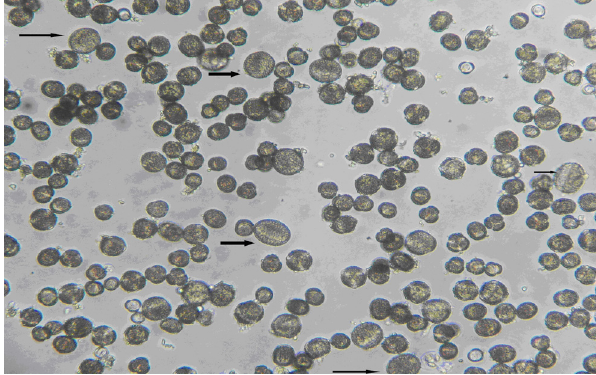
Fig. 2. Asynchronous population of microspores (40x) – arrows indicate embryogenic microspores At 5.8 value of pH, multicellular colonies emerging from microspore walls were observed during the second week of culture, while no colonies were observed in mi- crospores incubated on variants with pH higher than